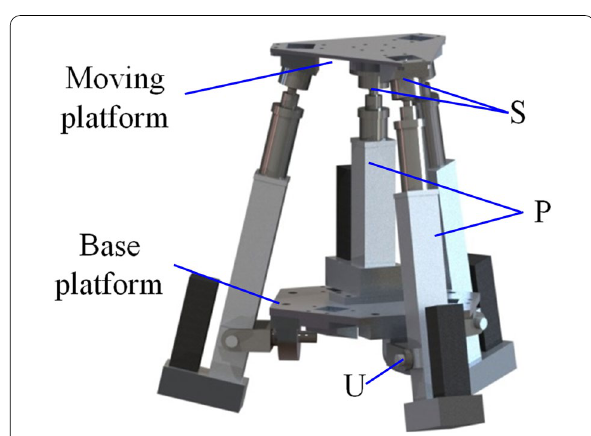
Figure 2 3UPS-PS unit module